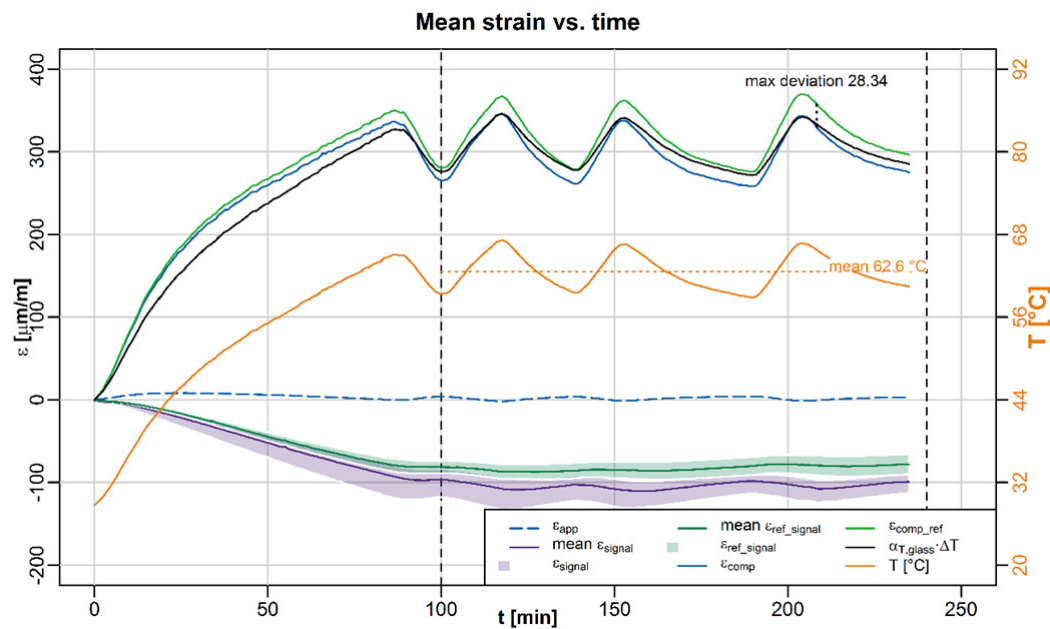
Fig. 8 Signals of unloaded specimen during heating, compensated signals and strain of the glass according to Equation (4). The apparent strain shows to be near zero.